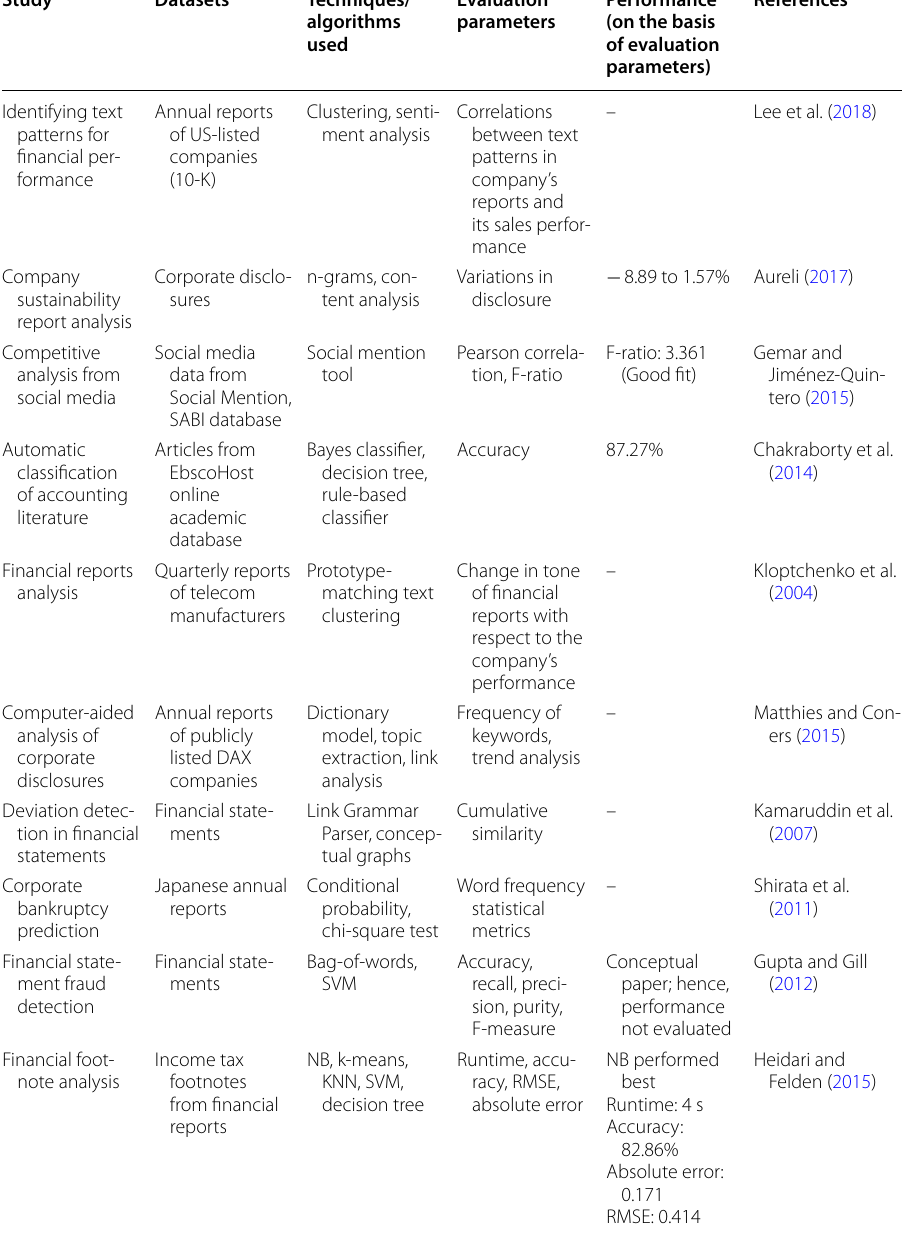
Table 3 Summary of recent research studies on some text‑mining applications for corporate